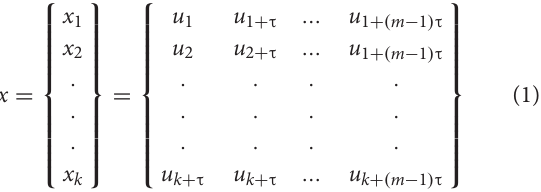
time series u i ( i = 1, 2, 3, . . . , L ) is usually embedded into an m -dimensional space using this method involving time